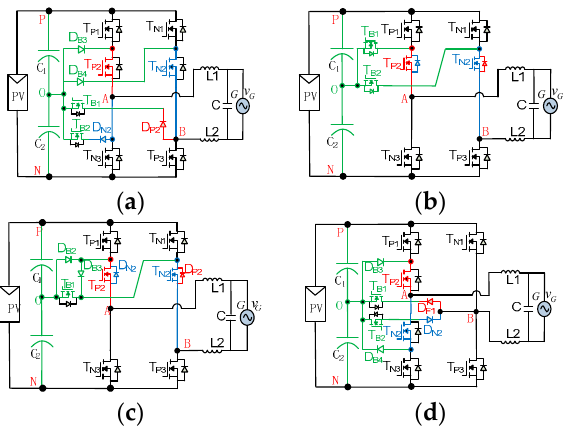
Figure 18. Direct Connection NPC topologies from M = 3, N = 3. ( a ) R6S2 (new); ( b ) R7S2-1 [47]; ( c ) R7S2-2 (new); ( d ) R8S2 (new).